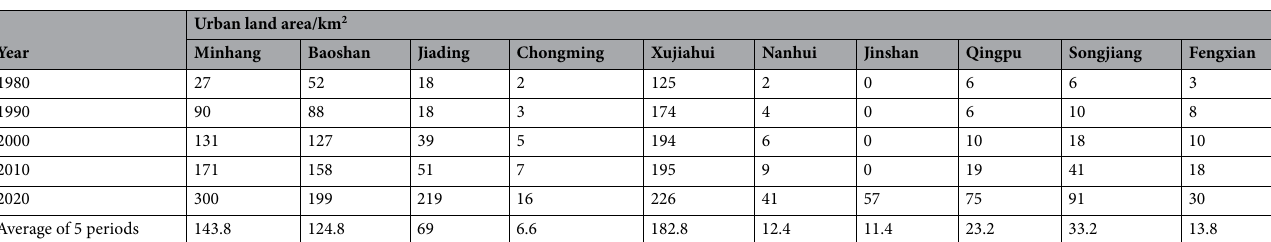
Table 6. The proportion of urban land area within 10 km of each